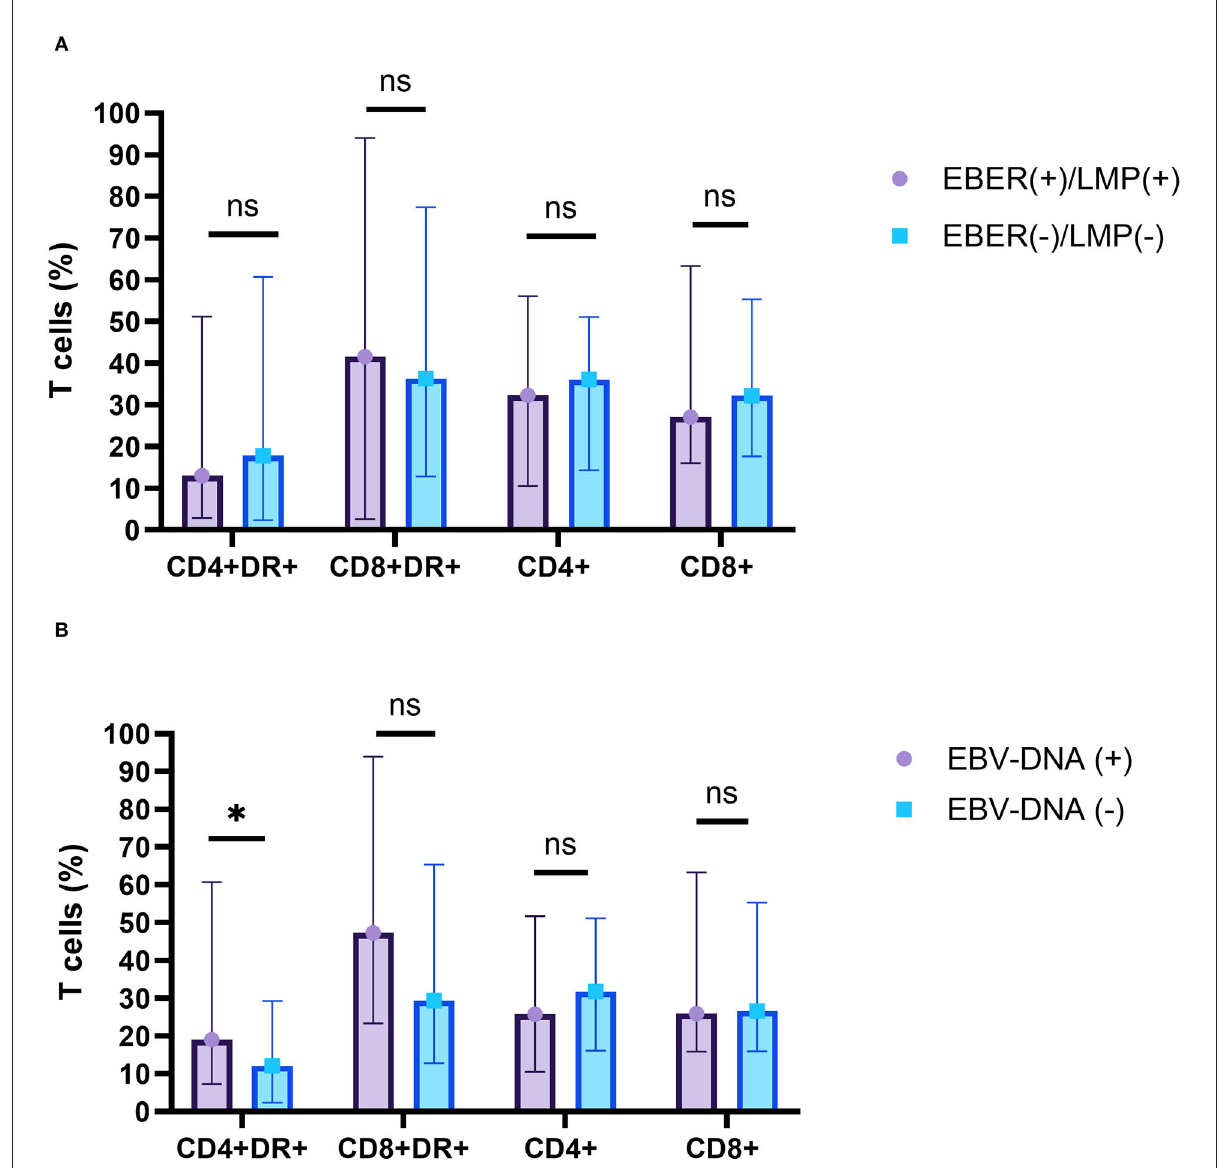
FIGURE5 The relationship between the percentage of T-cell subsets and EBV infections. (A) EBV-EBER- or LMP-1-positive patients (purple) and EBV-EBER- or LMP-1-negative patients (blue) in biopsy specimens. (B) EBV-DNA-positive patients (purple) and EBV-DNA-negative patients (blue) in serum. ns, not significant, p > 0.05; * p <